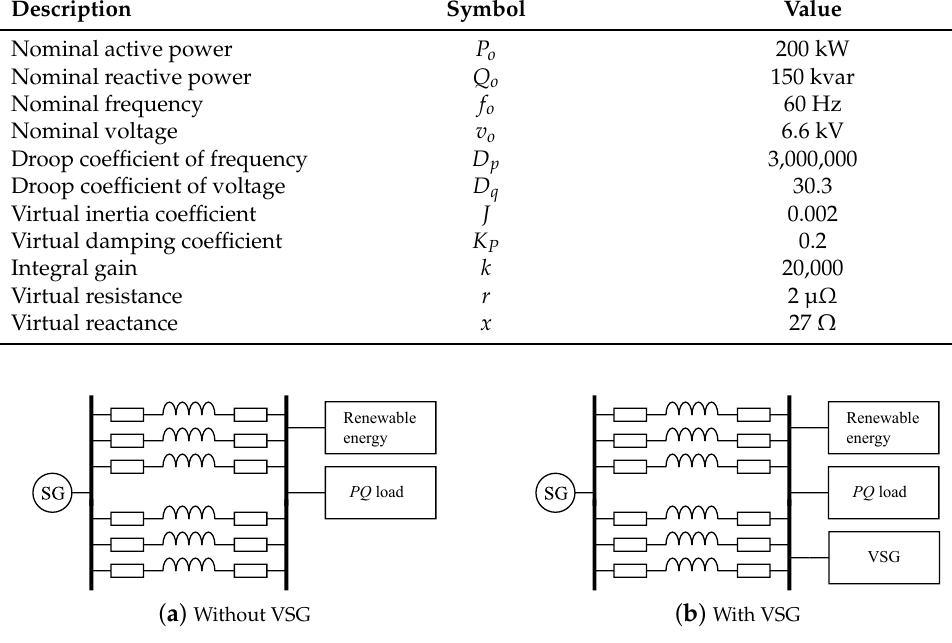
Figure 10. Remote island power system model with/without